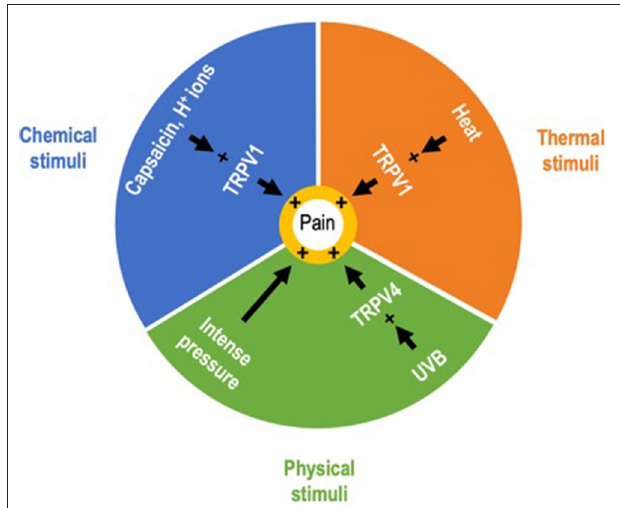
FIGURE 4 | Exogenous painful stimuli. Correspondence between keratinocytes and sensitive skin syndrome. Epidermal keratinocytes can transduce nociceptive information from exogenous stimuli belonging to the three categories of stimuli identified as provoking the unpleasant sensory perceptions characteristic of sensitive skin